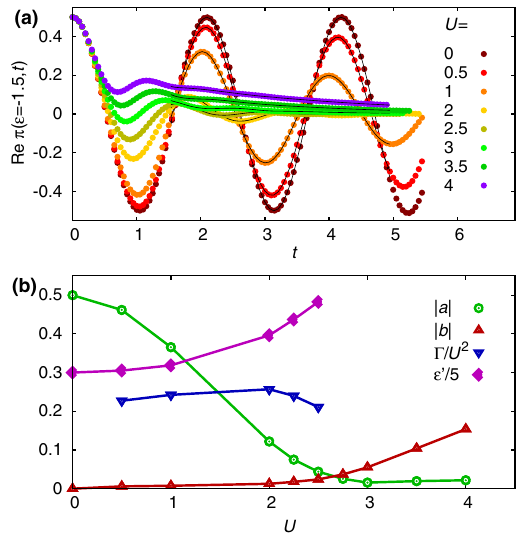
FIG. 3. (a) Line cut of π ð ϵ ; t Þ for ϵ ¼ − 1 . 5 and various values of U . Solid lines are fits with the sum of a decaying exponential background and decaying oscillations, f ð t Þ ¼ b exp ½ − c ð t − t plitudes of the background b , the oscillations a , the quasiparticle energy ϵ 0 , and the quasiparticle decay rate Γ as a function of U . (Note that Γ and ϵ 0 are no longer well defined if a becomes